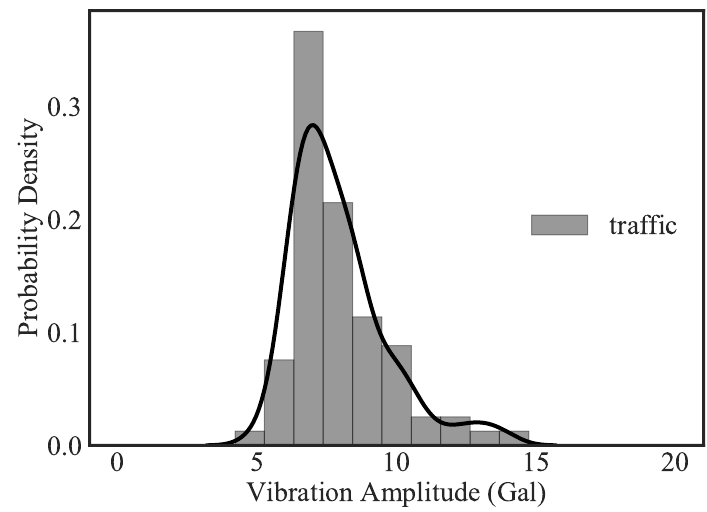
Figure 20. Probability density function plot of vibration amplitude for predicted tra ffi c records.